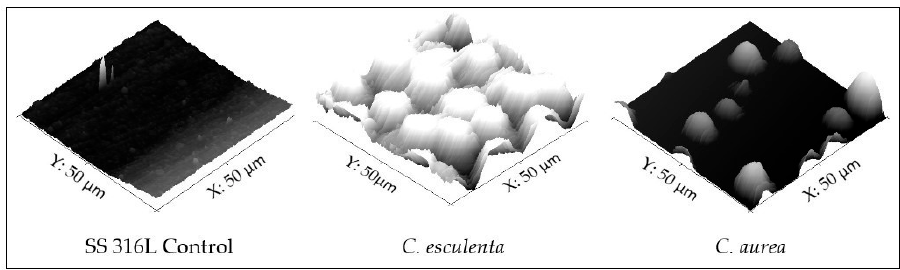
Figure 1. AFM images of a polished SS 316L (control) plate, C. esculenta and C. aurea leaves. Contact angle measurements from the three natural leaves exhibited high hydropho- bicity (contact angle > 120 ◦ ). The most hydrophobic leaf was S. molesta , followed by C. aurea and C. esculenta (Figure 2). The differences were statistically significant ( p <